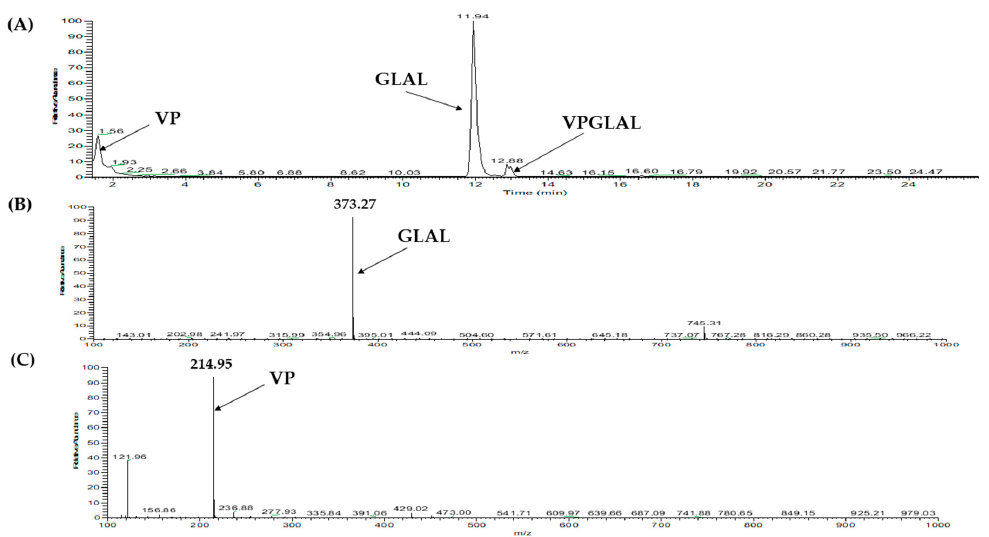
Figure A3. ( A ) LC-MS profile of VPGLAL pre-incubated with DPP-IV at 37 °C for 3 h. ( B ) The MS spectrum of fragment GLAL ( m / z 373.27), and ( C ) the MS spectrum of fragment VP ( m / z 214.95) derived from VPGLAL after pre-incubation with DPP-IV.